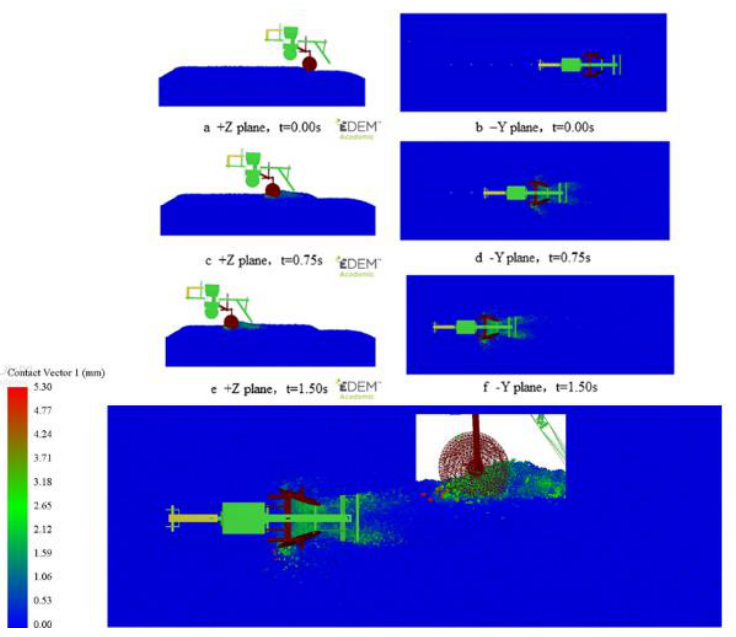
Figure 13. Screenshots of the soil covering